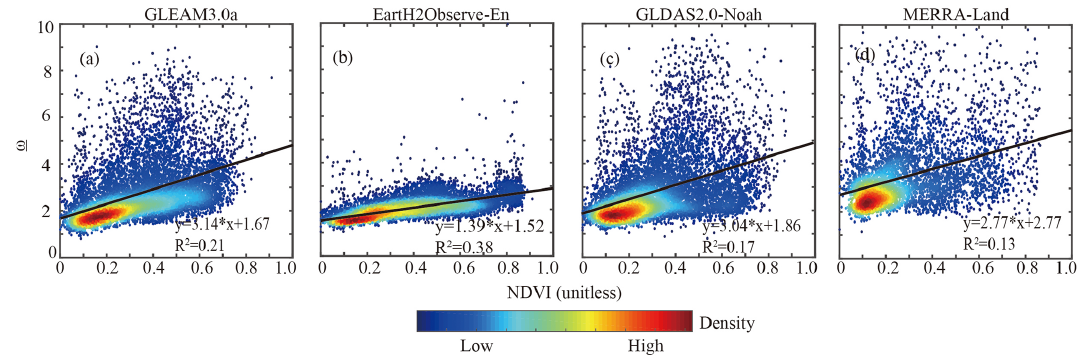
Figure 8. Pixel-wise scatterplots of ( x axis) multiyear average NDVI against ( y axis) their fitted ω values in each product. Small letters (a) – (d) represent GLEAM3.0a, EartH2Observe-En, GLDAS2.0-Noah, and MERRA-Land. The GIMMS NDVI data during 1982–2010 are used